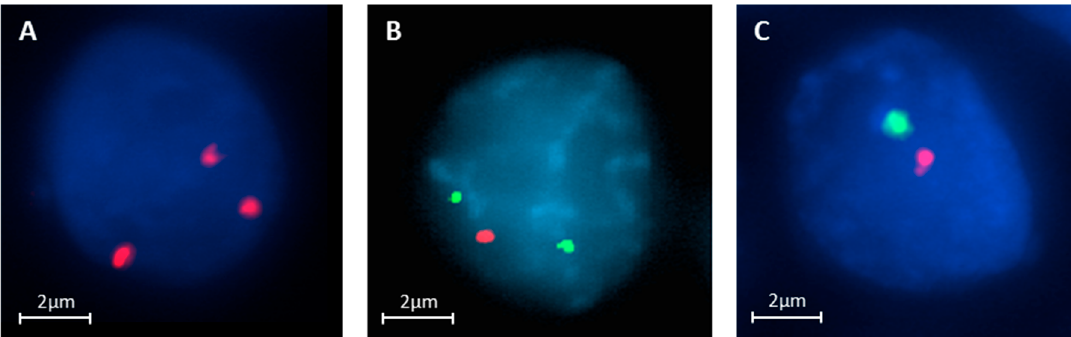
Figure 5. The Triple DNA FISH diagnostic assay illustrating the most common characteristic alterations detected in cFTC. ( A ) The three red signals show an X gain (female patient, Vysis CEP X / Y Abbott Laboratories, Abbott Park, IL, USA). ( B ) The two control green signals (1q25.3) and one red signal that is specific for 1p36.31 correspond to a loss of the 1p region (ZytoLight 1p36 / 1q25, ZytoVision, Bremerhaven, Germany). ( C ) One green signal (22q13.3) and one red signal (22q11.2) show a loss at 22q (LSI TUPLE 1 / LSI ARSA, Abbott Laboratories). Abbreviation: cFTC: classic follicular thyroid carcinoma.